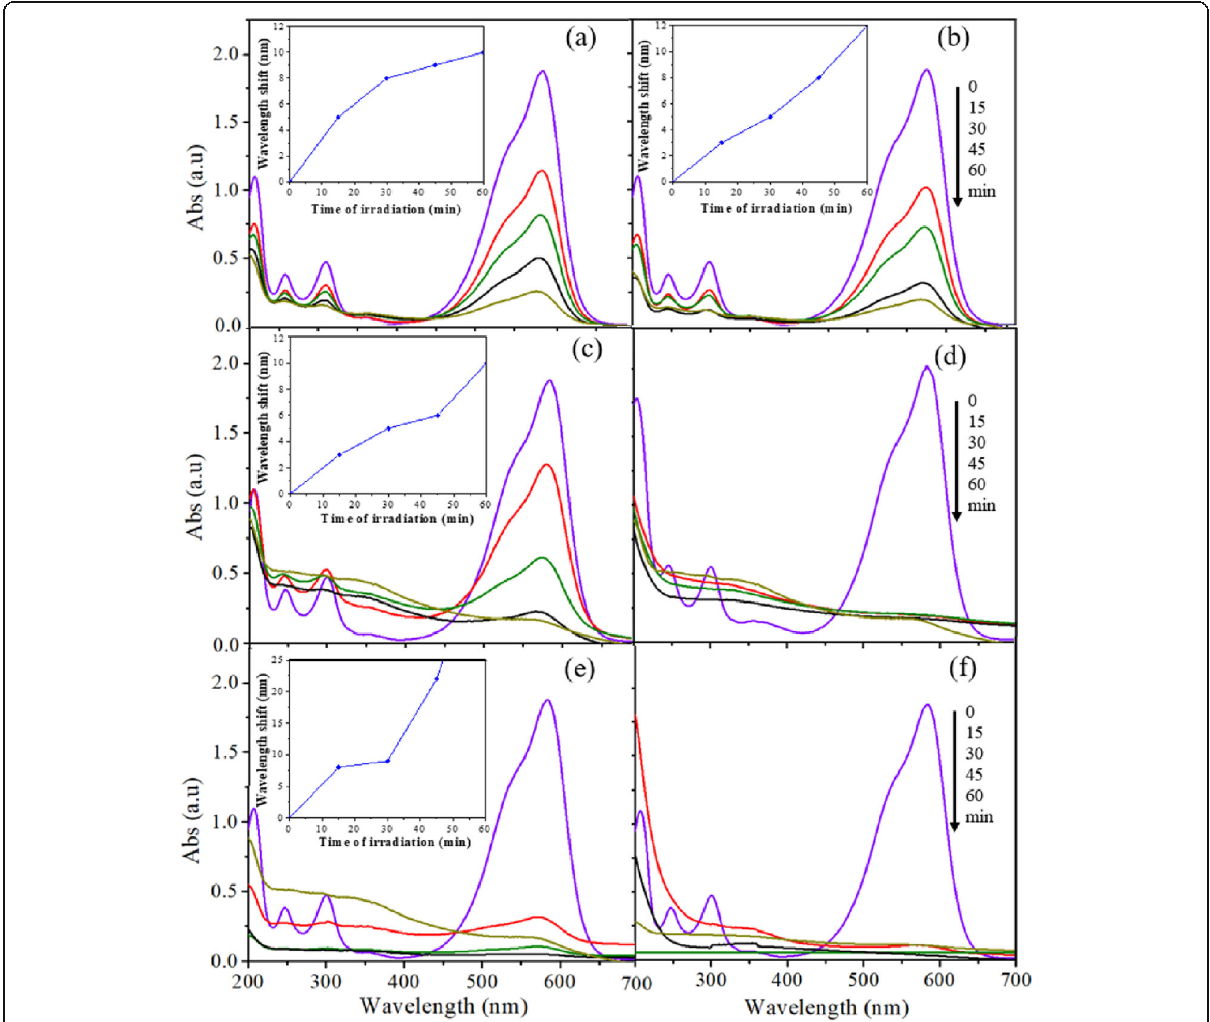
Fig. 7 UV-Visible spectra of treated solution by ( a ) photocatalysis using HAp, ( b ) photooxidation using HAp, ( c ) photocatalysis using HAp- n TiO 2 , ( d ) photooxidation using HAp- n TiO 2 , ( e ) photocatalysis using TiO 2 , and ( f ) photooxidation using TiO 2 [Initial MV concentration= 25 mg L − 1 , H 2 O 2 = 10 − 4 M, catalyst dosage = 0.25 g L − 1